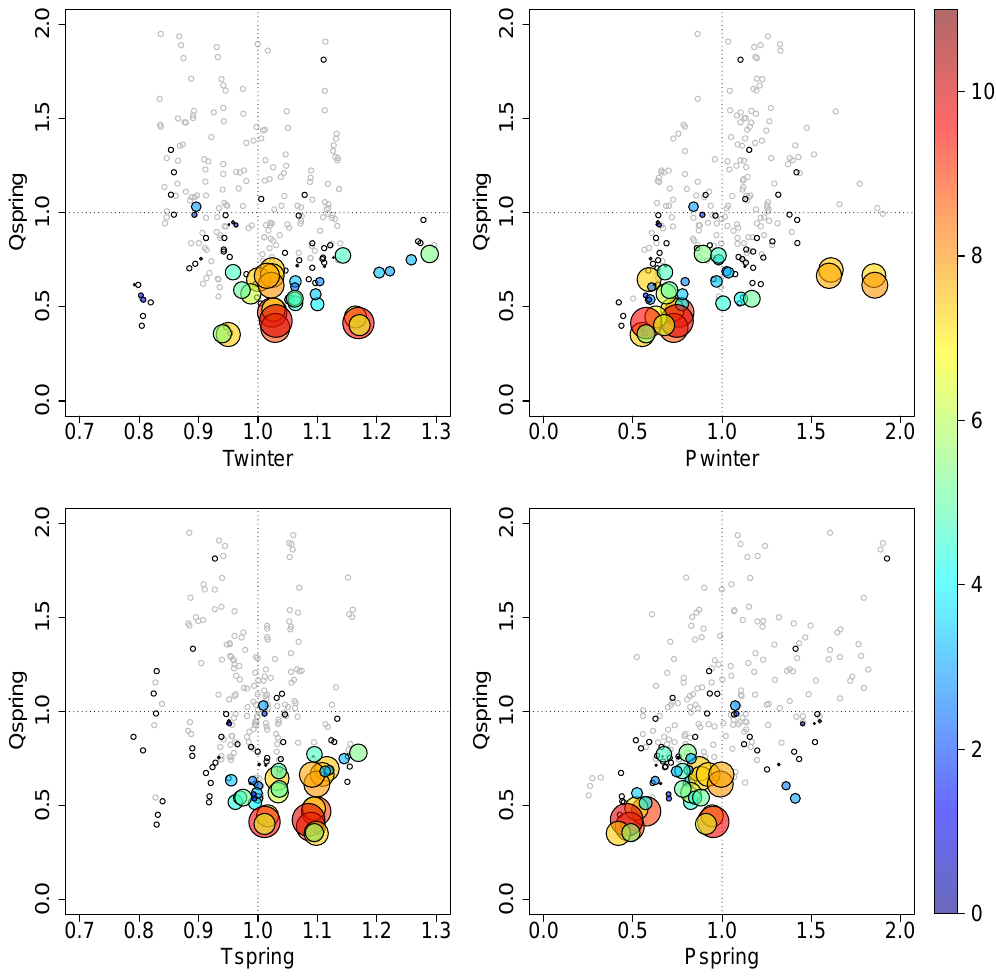
Figure 4. Snowmelt drought events in Austrian catchments: standardised spring discharge ( Q spring ) (–) against standardised causing factors ( T winter , P winter , T spring , P spring ) (–). Below 1 = below average; above 1 = above average. Grey circles: all years; black circles: all drought years; coloured circles: snowmelt drought years (size and colour of dots are dependent on standardised drought deficit (–); scale on the right side of the figure).